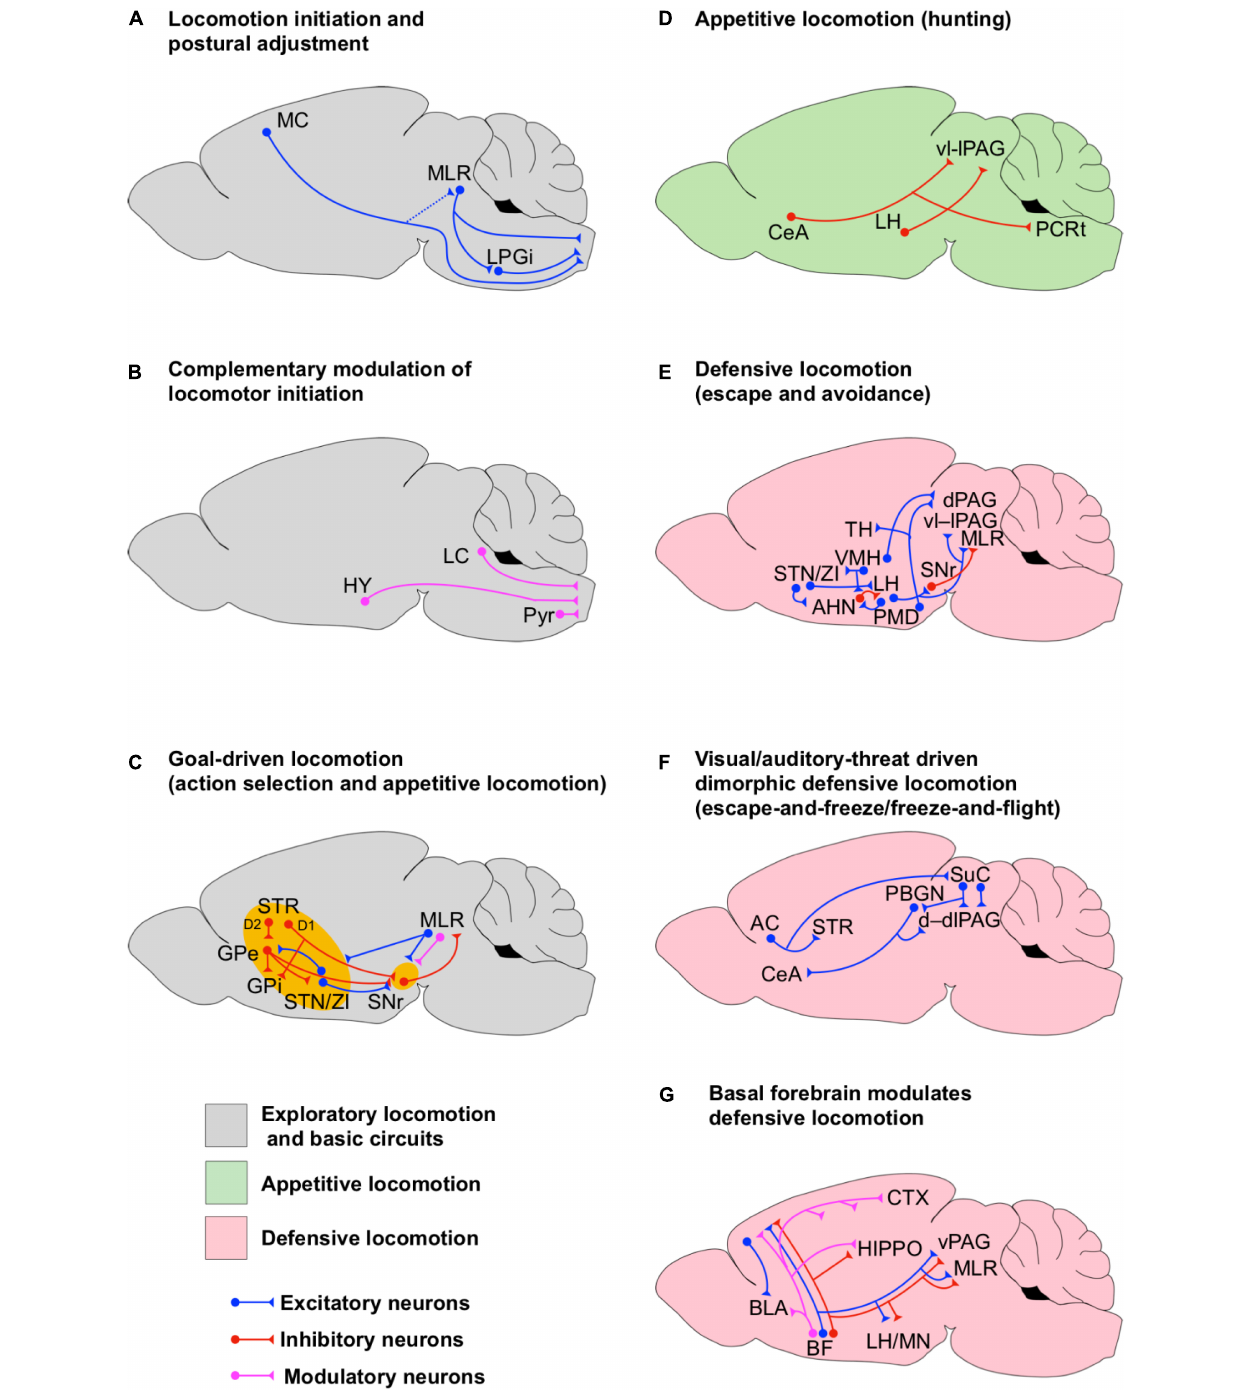
FIGURE 1 | Circuits for state-dependent initiation of locomotion. (A) Scheme of the basic neuronal circuits underlying the initiation of locomotion. The dotted line between the motor cortex (MC) and the MLR denotes minor monosynaptic contacts between both areas in rodents. (B) Scheme of the neuronal circuits underlying the complementary modulation of the initiation of locomotion. (C) Scheme of the neuronal circuits underlying the initiation of goal-driven locomotion. These circuits account for action selection and appetitive locomotion. Note the interconnections between BG and MLR. The BG circuits are highlighted in yellow to indicate that they are involved in the initiation of a particular state even if they are not fully shown for simplicity. (D) Scheme of the neuronal circuits underlying the initiation of appetitive locomotion. (E) Scheme of the neuronal circuits underlying the initiation of defensive locomotion. (F) Scheme of the neuronal circuits underlying the initiation of dimorphic defensive locomotion (escape-and-freeze and freeze-and flight). (G) Scheme of the basal forebrain neuronal circuits underlying the modulation of defensive locomotion.